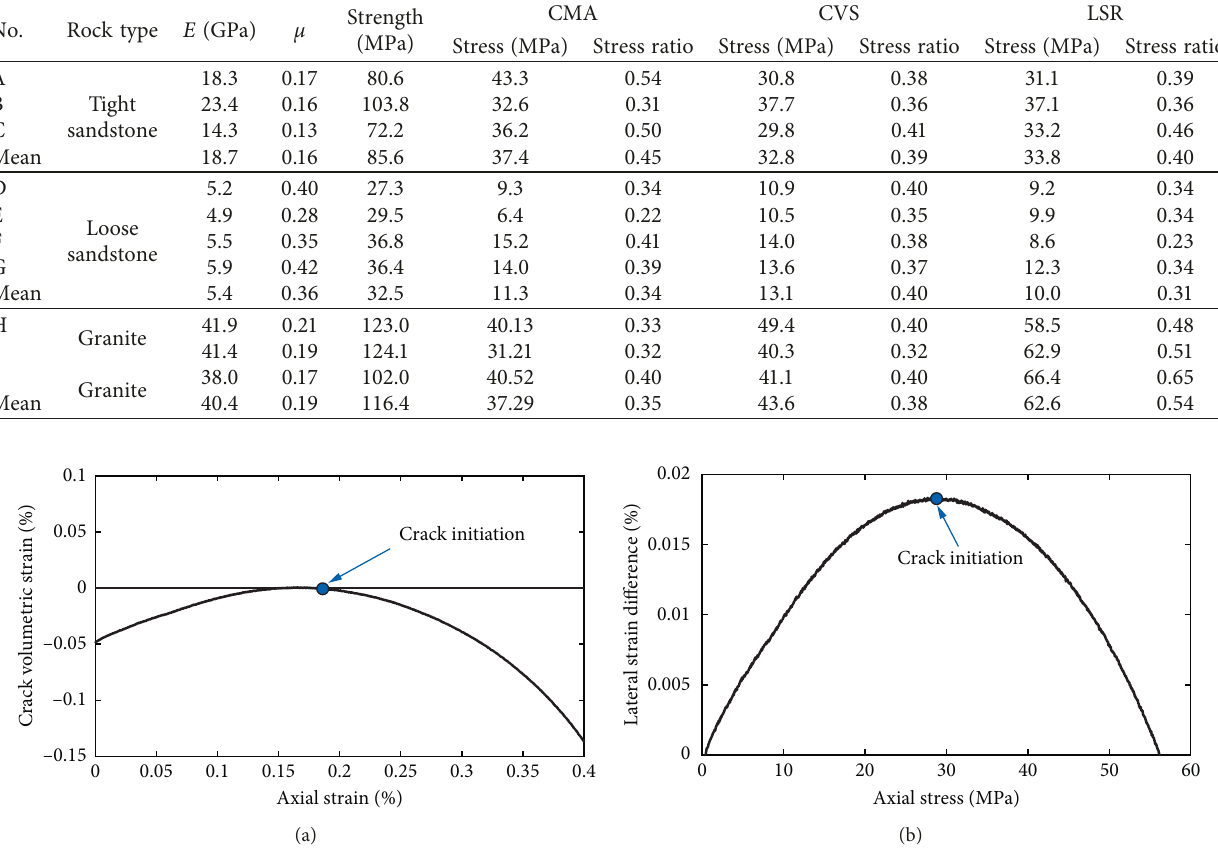
Figure 7: Crack initiation stress determination from uniaxial testing conducted with different methods. (a) CVS method [13]. (b) LSR method [15].